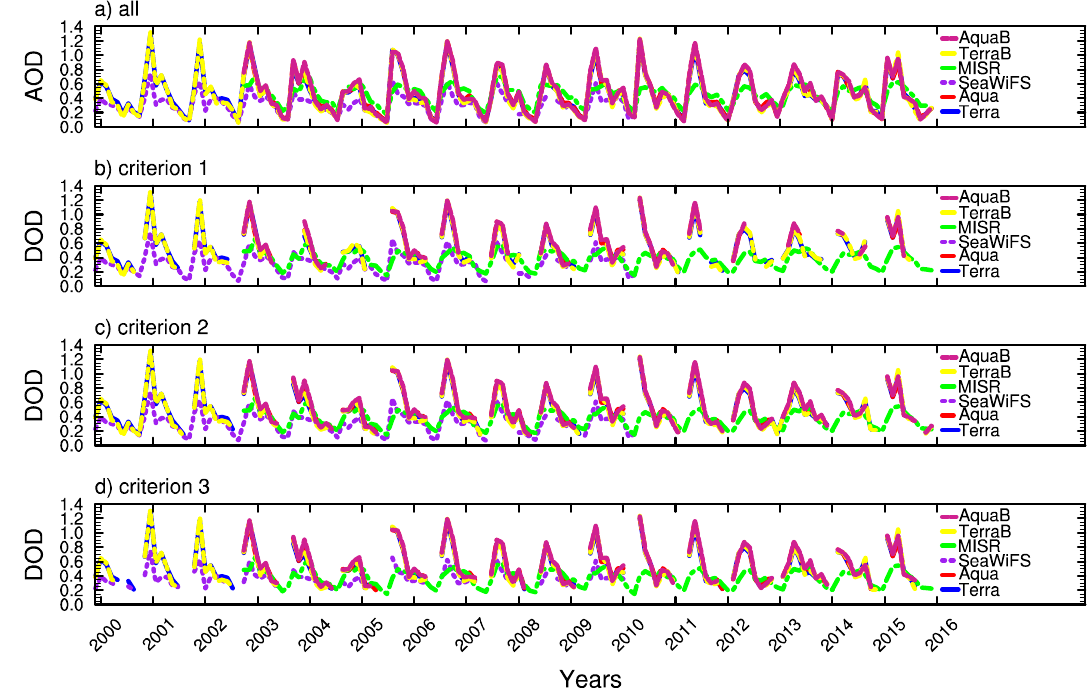
Figure 7. Same as Figure 6, but for the Taklimakan Desert.